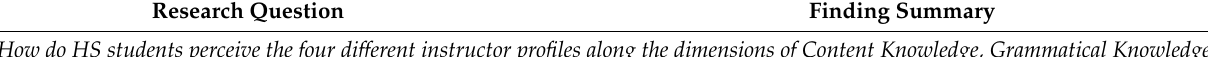
Table 5. Summary of main